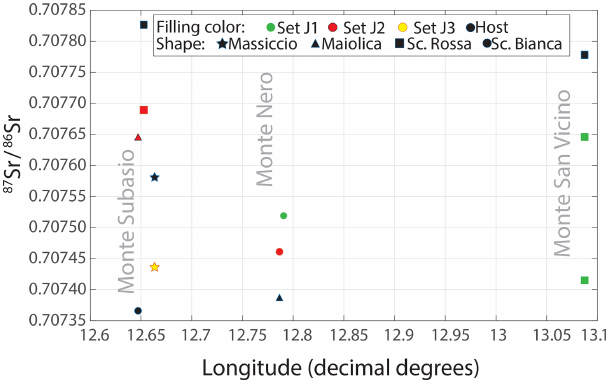
Figure 7. Plot of 87 Sr / 86 Sr values vs. longitude, with filling colour related to tectonic set and point shape related to host rock formation. Note that the host-rock values are equivalent to the related forma- tion seawater values.